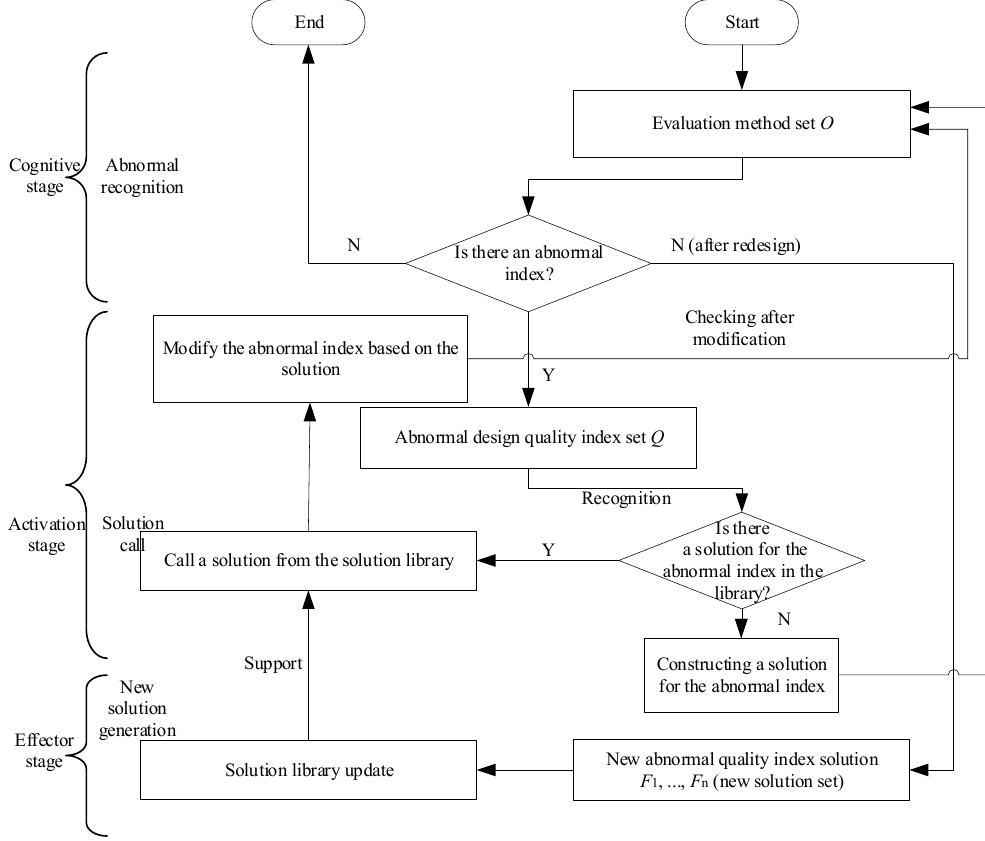
Figure 5. Micro-level model quality optimization model.